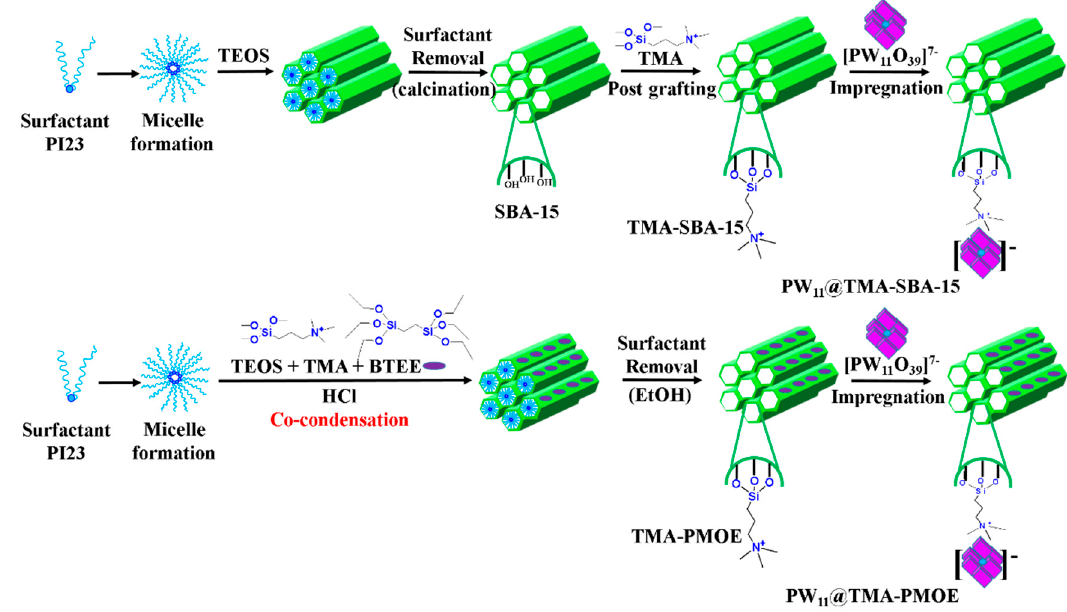
Figure 3. Synthetic strategy to prepare Keggin’s polyoxometalate anion incorporated PW 11 @TMA- (SBA)-15 and PW 11 @TMA-PMOE [101].